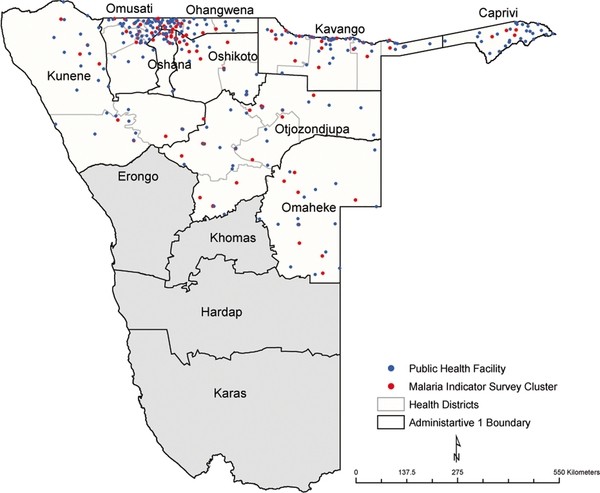
Location of the 2009 MIS clusters shown as red dots (N = 120) in relation to public health facilities shown as blue dots (N = 245) in the nine northern provinces of Namibia where the 2009 MIS was undertaken (Kunene, Omusati, Oshana, Ohangwena, Otjozondjupa, Omaheke, Kavango and Caprivi). Subsequent analysis was restricted to only these nine regions.